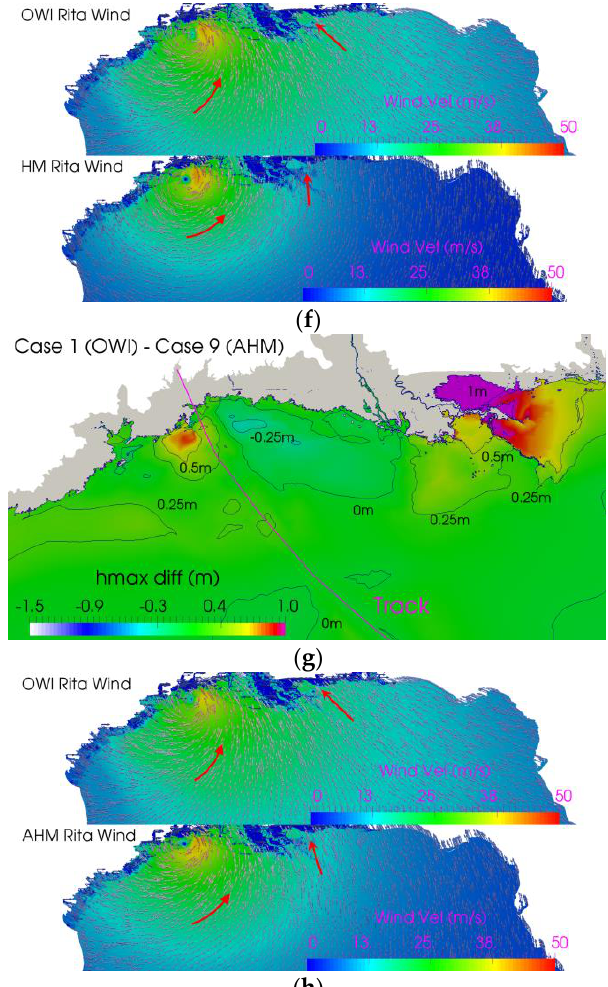
Figure 9. Differences of maximum water elevation in comparison to default case (i.e., ‘hmax diff’) and wind velocity vector snapshot at 8:30 AM on 24 September 2005 (i.e., ‘wind vel’). ( a , b ) Case 1 vs. 6; ( c , d ) Cases 1 vs. 7; ( e , f ) Cases 1 vs. 8; and ( g , h ) Cases 1 vs. 9.